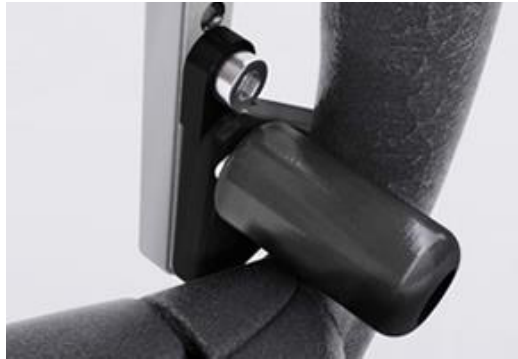
Figure 2. Tactile supporting point of the balance (DSA, 2016) This balance gets attached on the steering wheel manually and measures the current rotation angle of the steering wheel to the horizontal. Steering wheel balances are getting distributed by companies like Dürr AG (Dürr, 2016b) or DSA (DSA, 2016). Duerr AG specifies its steering wheel balance named x-tronic balance within a measuring accuracy of 0.1° (Dürr, 2016a). Additional to this uncertainty, a dimensional tolerance has to be added caused by slight deviations of the (tactile) attachment (Figure 2).